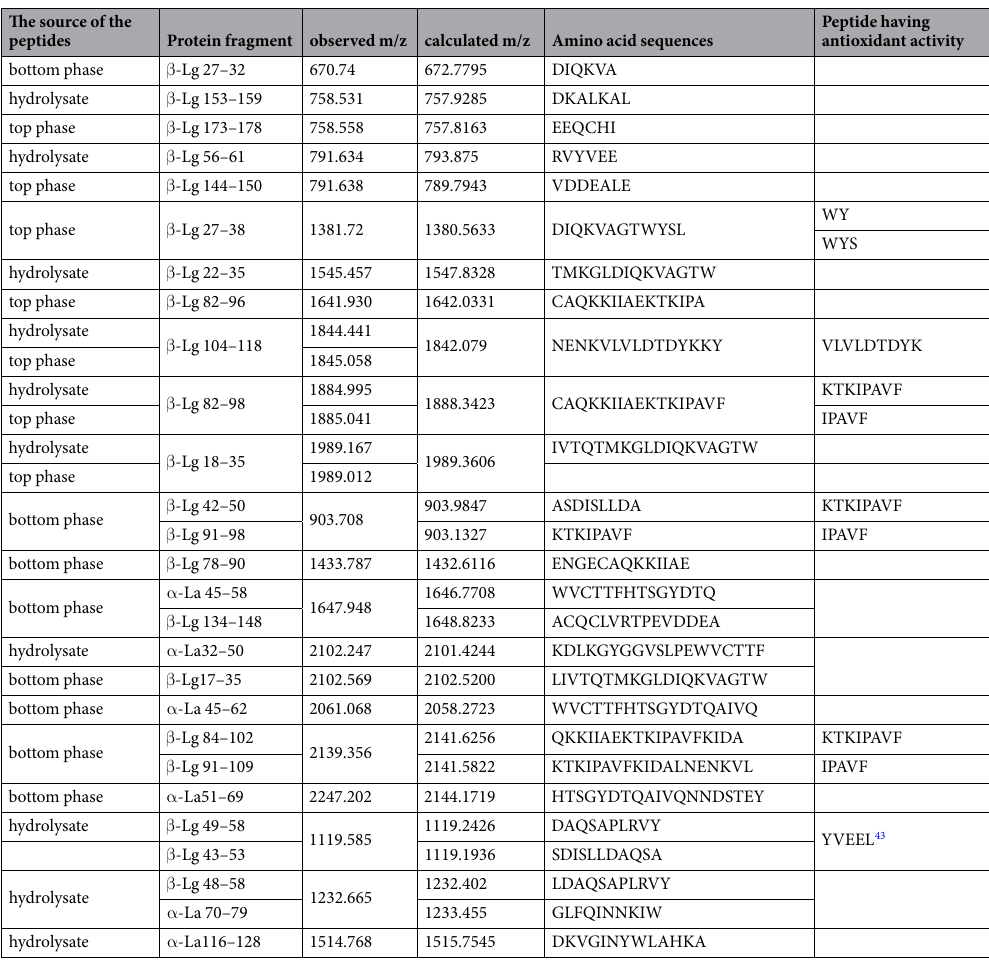
Table 6. Amino acid sequences of peptides from different